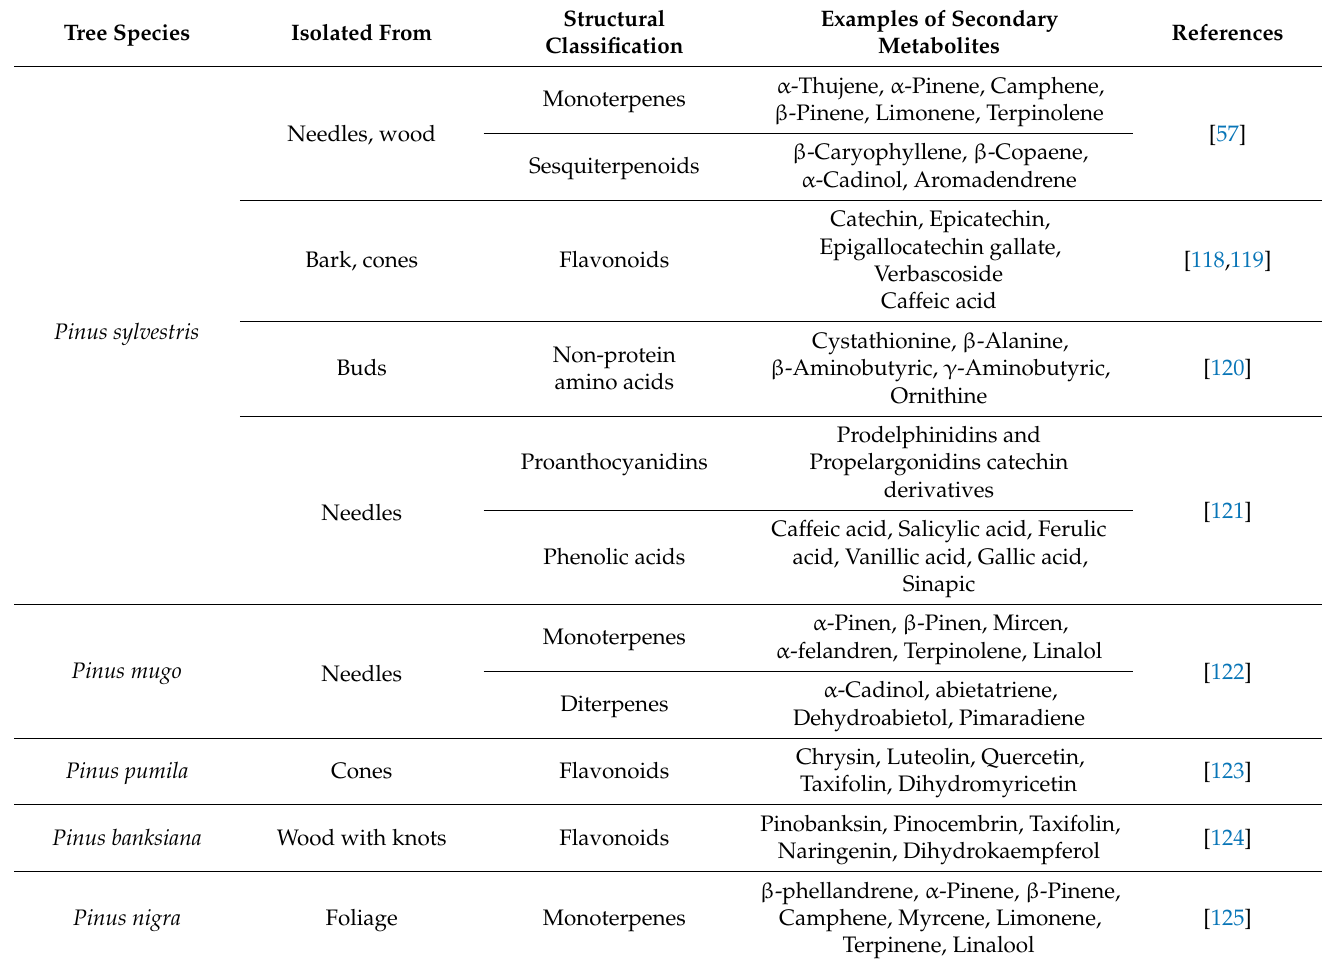
Table 1. Secondary metabolites produced by gymnosperm